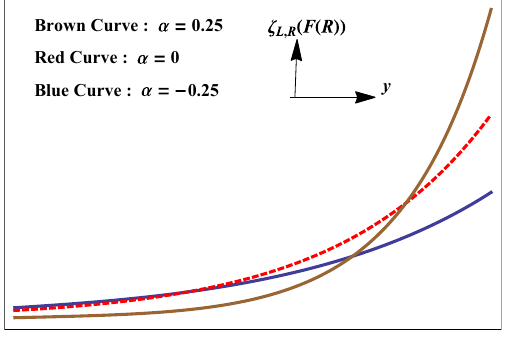
Fig. 3 ζ R ( = ζ R ( F ( R )) in the diagram) vs. y for M = 1, (cid:9) = − 1 and m 5 = 0 .